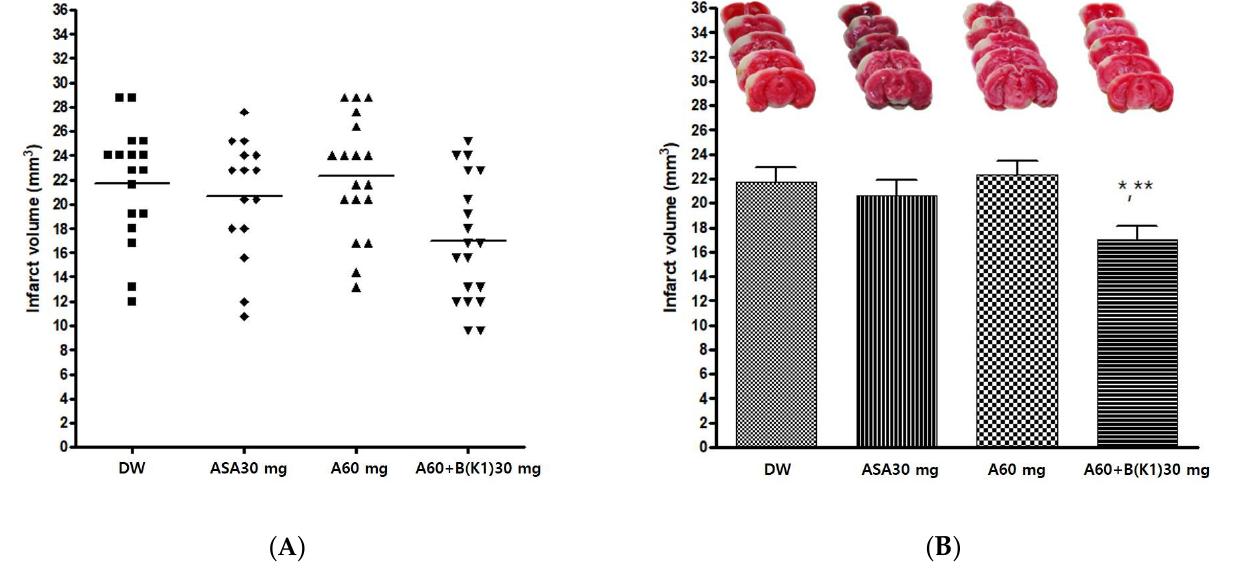
Figure 4. Effects of experimental drug A60+B(K1) 30 mg/kg on ischemic brain injury after permanent middle cerebral artery occlusion (pMCAO). Infarct volume was measured 24 h after pMCAO. DW and all drugs were administered just before pMCAO. ( A ) Individual infarct volume values for each group (n = 15 – 19 mice for each group). ( B Upper ) Representative photographs of infarcted brain slices from DW- and drug-treated mice. ( B Lower ) The group of experimental drug A+BK1 exhibited a significant decrease in infarct volume after pMCAO compared to groups DW and A60. DW, dis-